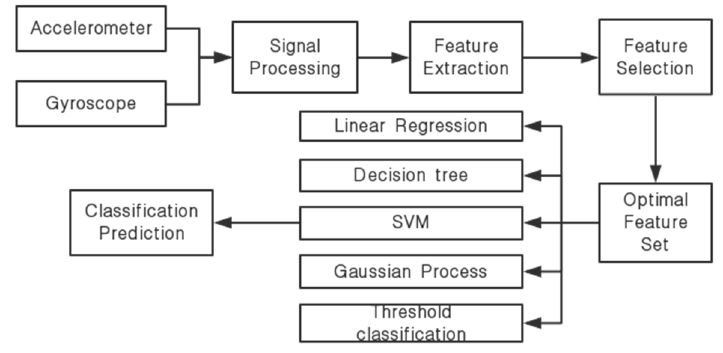
Figure 1. Human activity recognition framework.